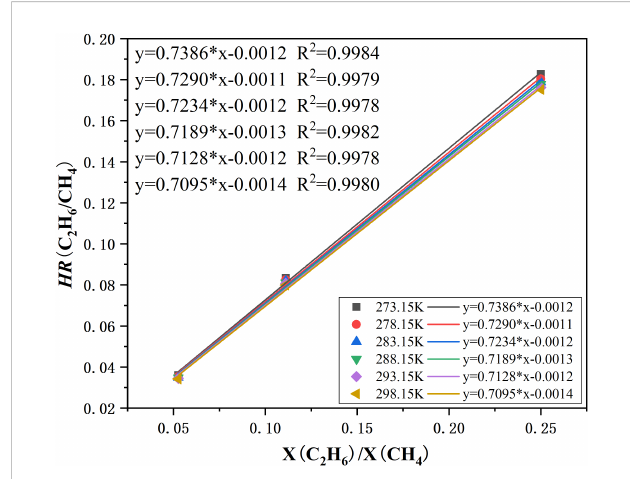
FIGURE 4 Calibration curve for the CH 4 and C 2 H 6 system based on vapor mixtures at 30 MPa. The ordinate is the Raman peak height ratios. The abscissa is the mole fraction ratios of CH 4 and C 2 H 6 gas. The linear functions ’ corresponding temperatures are indicated.